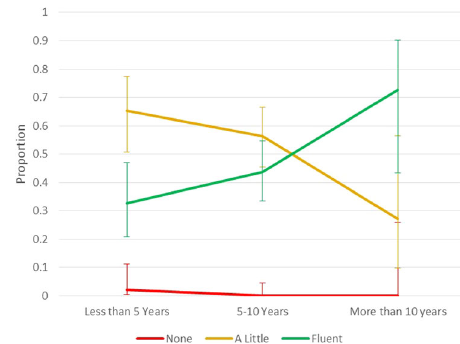
Fig. 4 Spoken Malay language skills for respondents who arrived aged 18 or less, by time in Malaysia. Vertical bars represent 95% con fi dence intervals on population proportions.